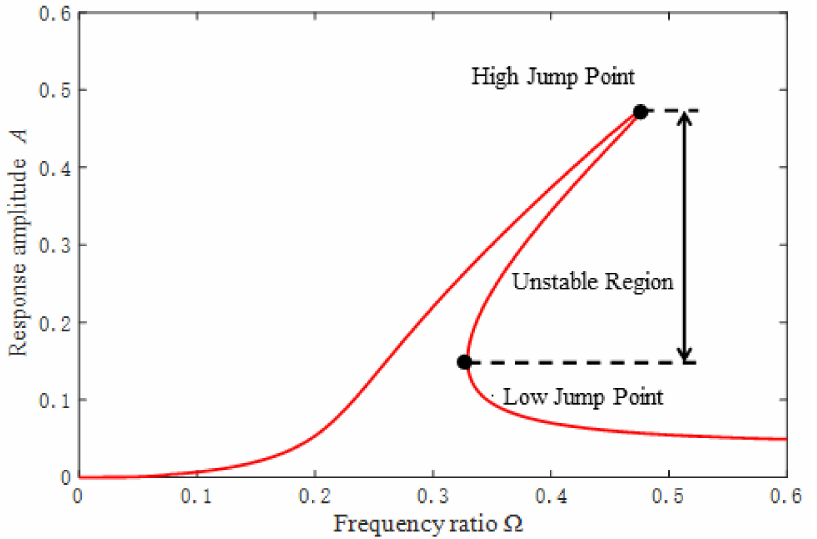
Figure 3. The amplitude–frequency characteristic